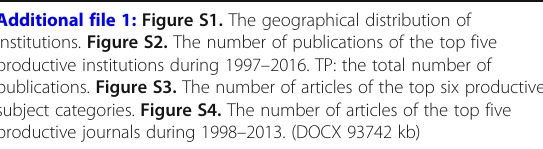
Additional file 1: Figure S1. The geographical distribution of institutions. Figure S2. The number of publications of the top five productive institutions during 1997 – 2016. TP: the total number of publications. Figure S3. The number of articles of the top six productive subject categories. Figure S4. The number of articles of the top five productive journals during 1998 – 2013. (DOCX 93742